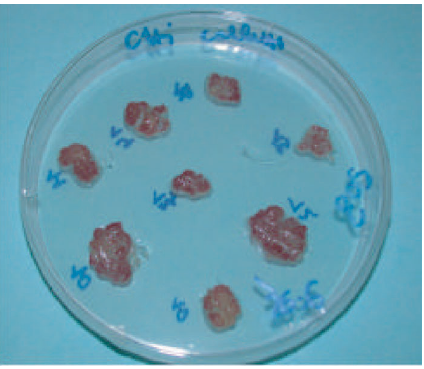
Figure 2. Callus culture of sour cherry ( P cerasus L) cv Amarena Mattarello on callus induction medium, after ten days of light exposure.